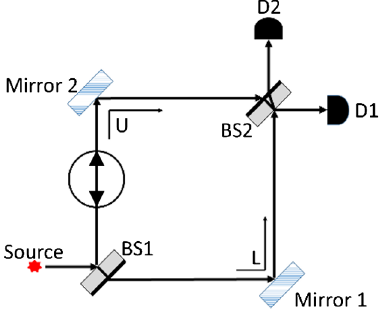
FIG. 3. Basic MZI setup.